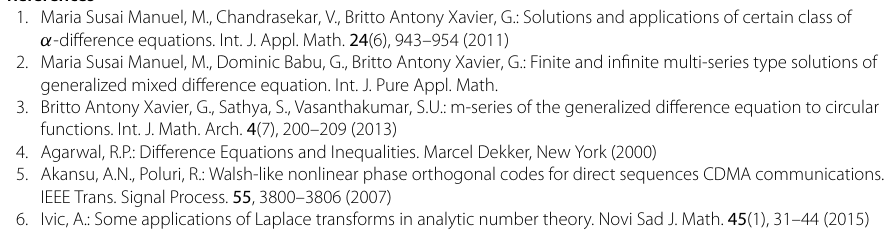
one. As a very important findingof this research, when α = ν = 1, we get the Laplace trans- form existing in the